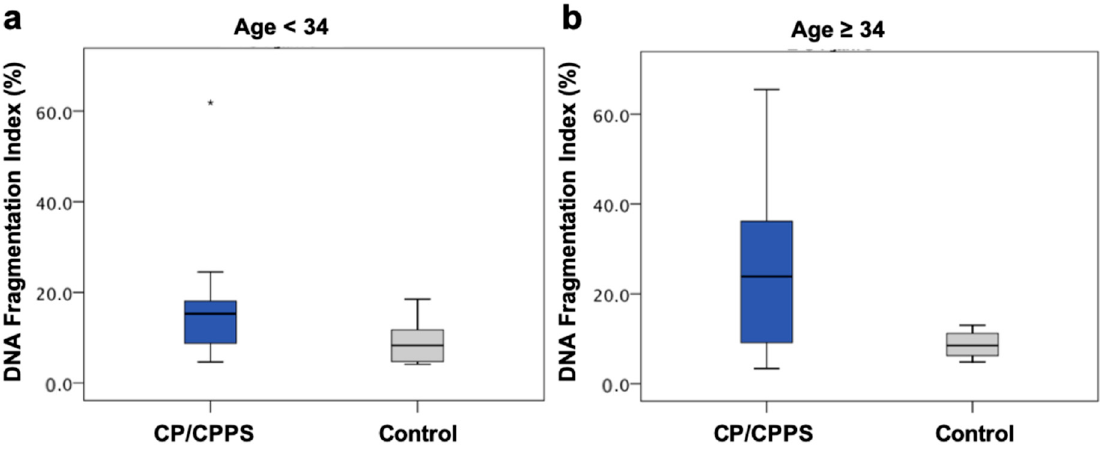
Figure 3. DFI compared after building age-matched groups: ( a ) Age < 34 years DFI: 15.3% (CP/CPPS, n = 11, * marks an outlier) vs. 8.3% (Control, n = 17), p < 0.05. ( b ) Age ≥ 34 years DFI: 23.8% (CP/CPPS, n = 30) vs. 8.5% (Control, n = 5), p = 0.094.